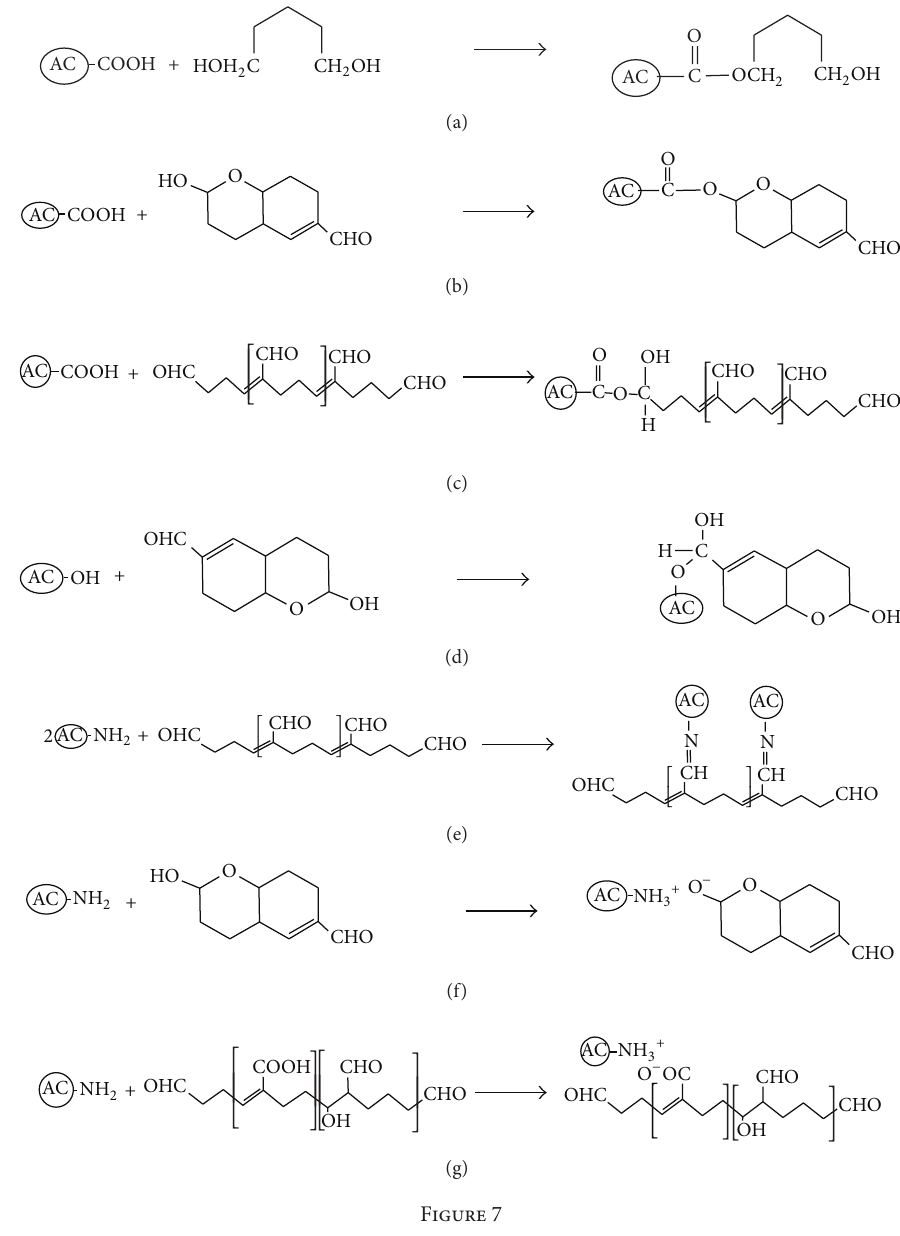
Table 4: Isotherm parameters for sorption of glutaraldehyde on EDA-AC. Freundlich